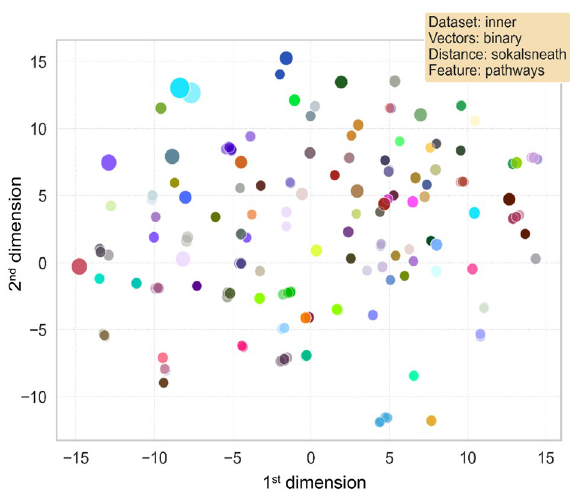
Figure 4. Visualization of the second analysed model obtained performing OPTICS. Each point represents a disease, plotted in the two-dimensional space obtained once applied PCA and t-SNE to the pathways feature matrix related to the complete set of diseases. Different colours symbolize different clusters. The size of the points ranges accordingly to the clusters’ size. Only clusters containing more than 15 diseases have been represented for the sake of clarity (a total of 409 diseases).